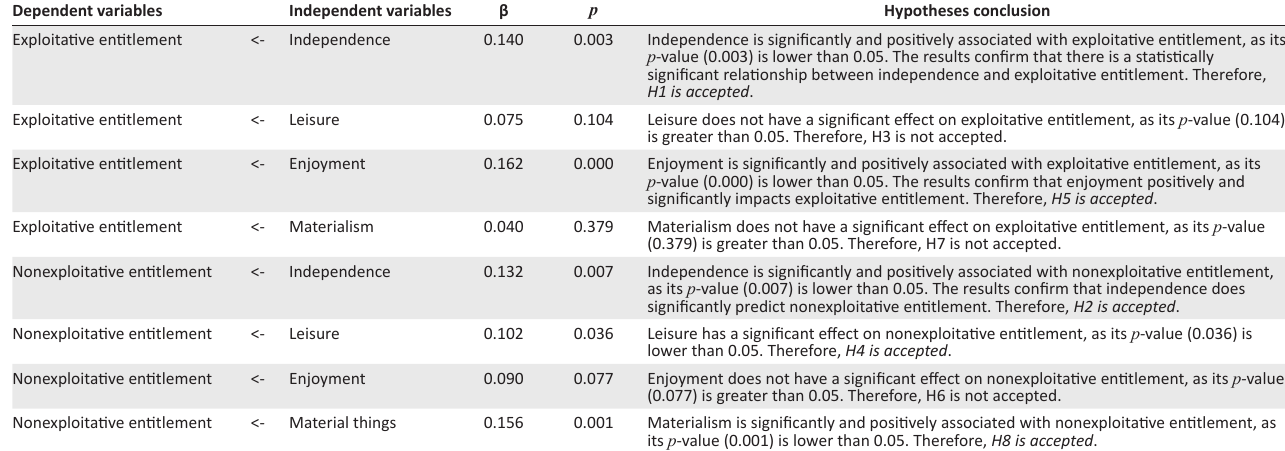
TABLE 4: Standardised regression weights and hypothesis